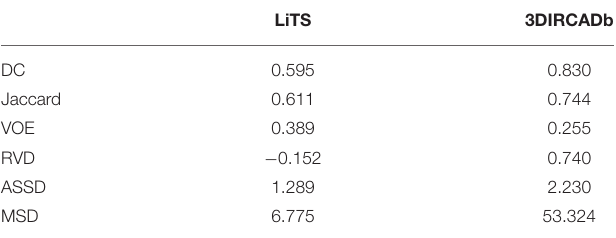
TABLE 4 | Scores of the tumor segmentation on the LiTS test dataset and the 3DIRCADb dataset.